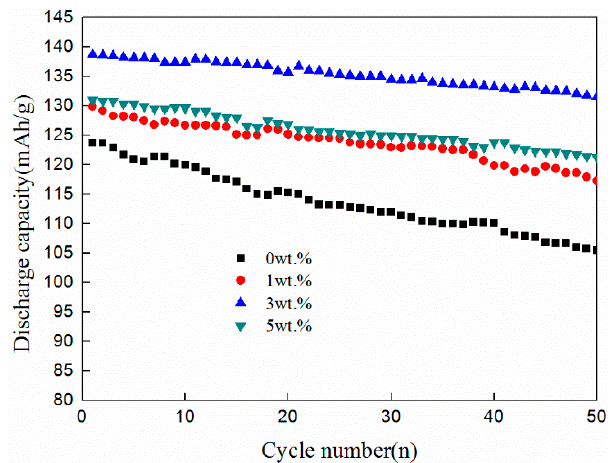
Figure 6. Cycle performance (discharge capacity) comparison of LFP/C-xZnO (x = 0, 1 wt%, 3 wt%, 5 wt%) at 0.1 C.